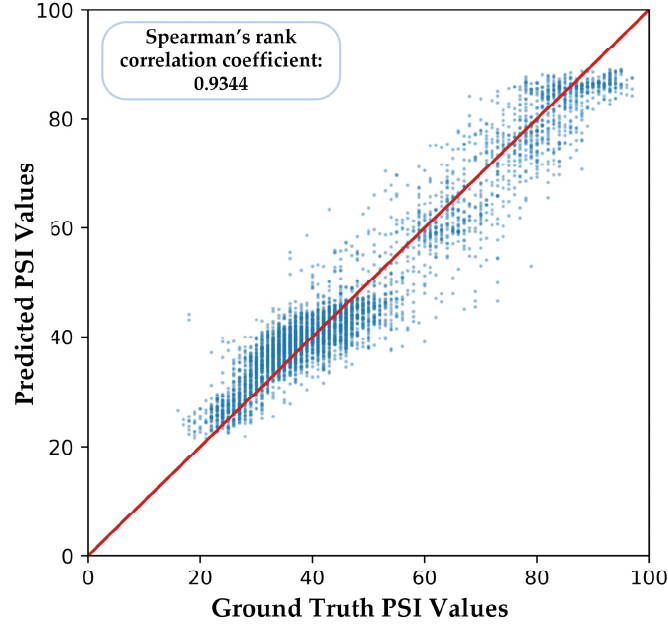
Figure 9. Part of the predicted PSI values of our proposed model. The red line represents the ideal prediction model where the predicted PSI values equal the ground truth PSI values exactly.